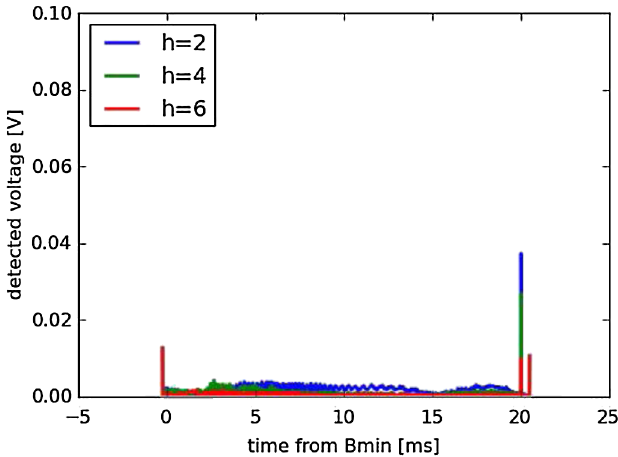
FIG. 10. The harmonic components of the gap monitor signal with